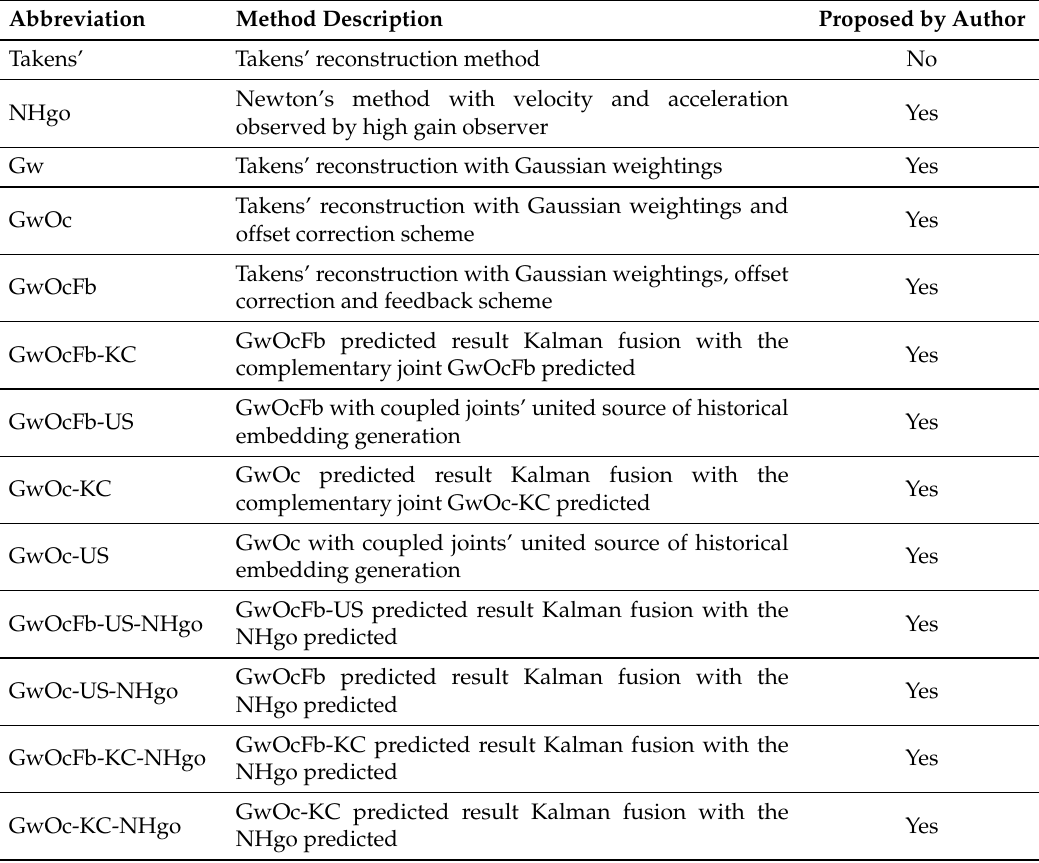
Table 1. Prediction methods in this article and their abbreviations.